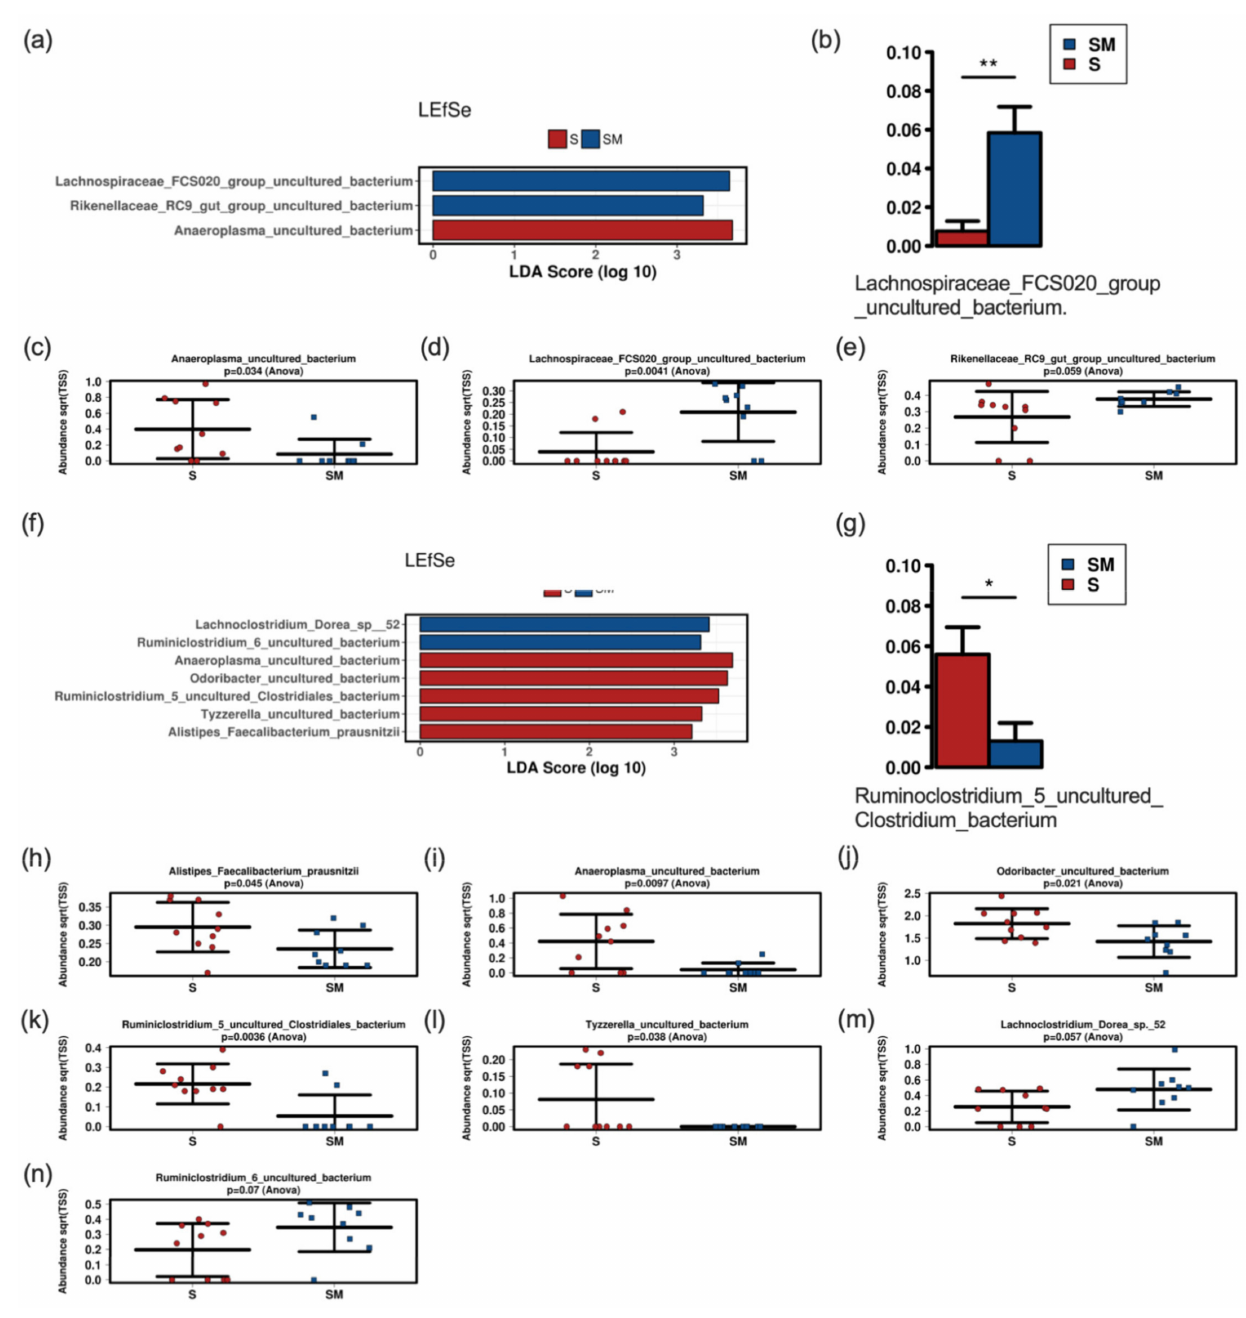
Figure 7. LEfSe ( a , f ) and ANCOM ( b , g ) analysis with bar charts ( c – e , h – n ) of fecal samples of mice treated with the 48 h ( a – e ) and the 196 h ( f – n ) postbiotic supernatant versus mice treated with culture medium. S, supernatant; SM, medium control. * significant difference ( p < 0.05), ** significant difference ( p <